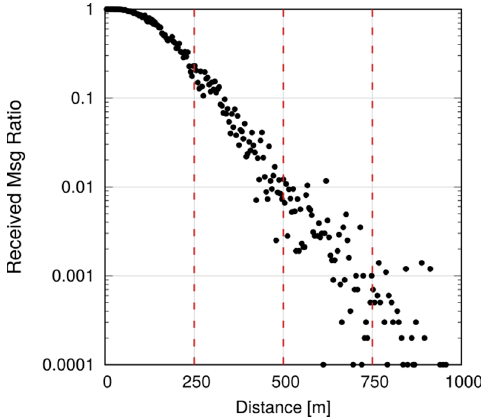
Figure 26. Reception probability of a P2MP D2D transmission.